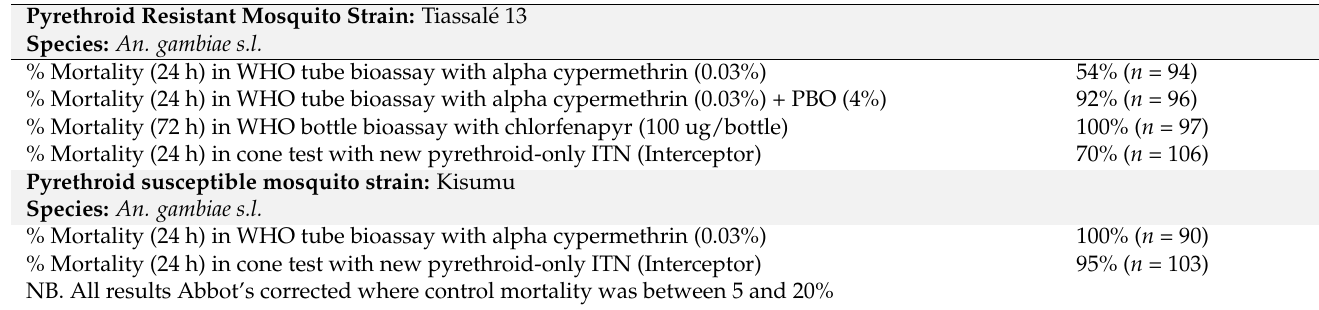
Table 3. Characteristics of a pyrethroid resistant and susceptible mosquito strain used for bioefficacy monitoring of dual-AI nets (an example is a strain used to monitor Interceptor G2, chlorfenapyr + alpha-cypermethrin ITN). Recommended format for presenting the results of strain characterisation should be provided alongside bioefficacy testing with dual-AI